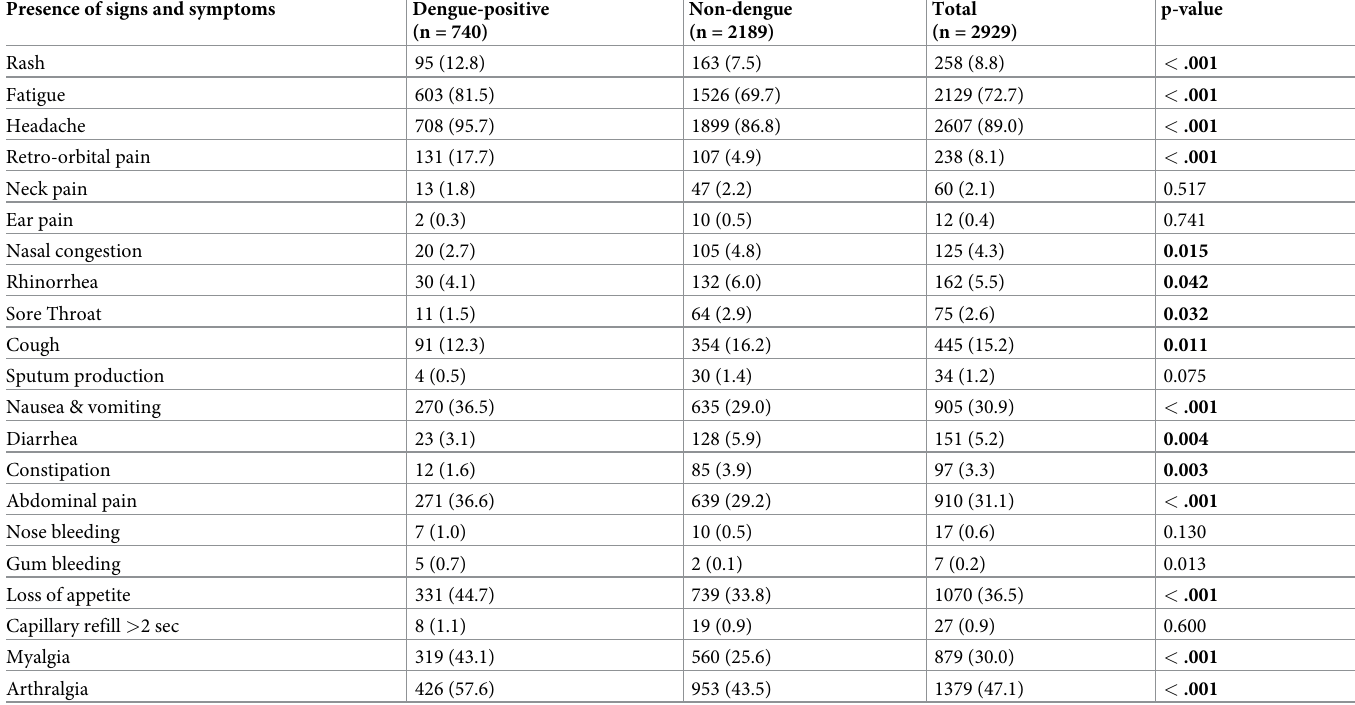
Table 2. Signs and symptoms of dengue-positive and non-dengue cases in the facility-based fever surveillance established in Ouagadougou, Burkina Faso, between December 2014 and February 2017. Presence of signs and